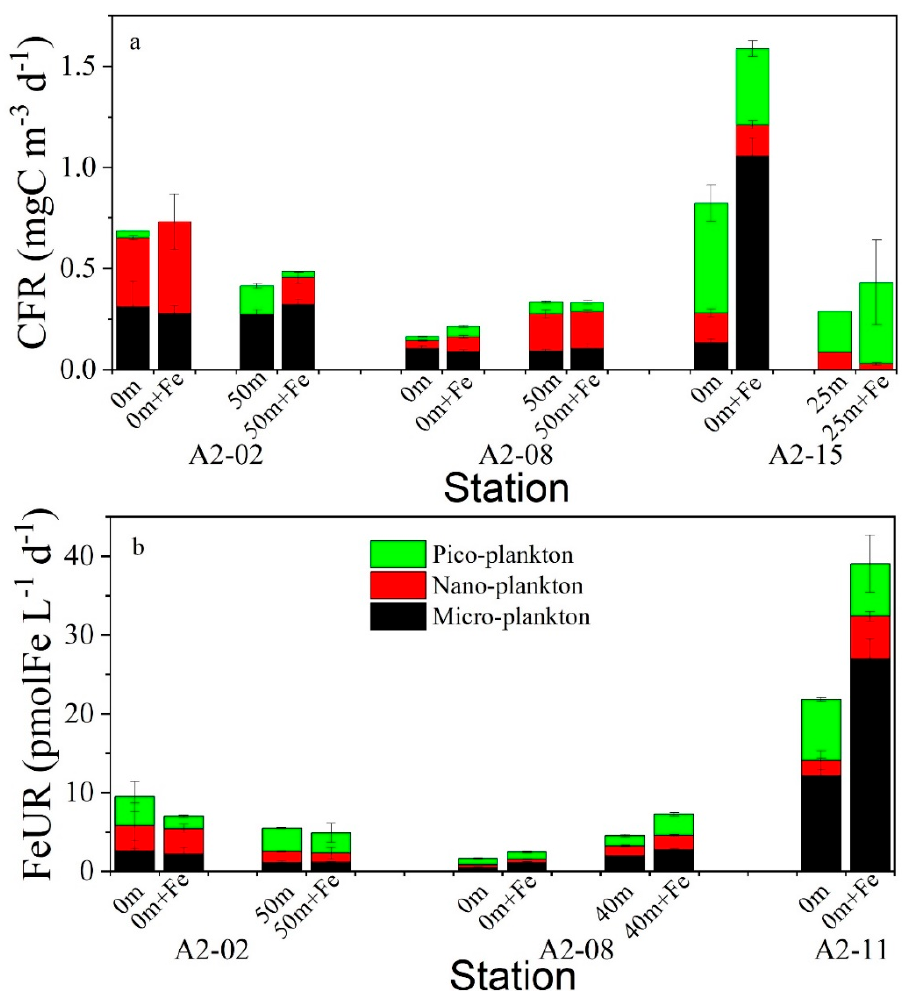
Figure 7. Effects of the DFe addition on the size-fractionated CFR ( a ) and FeUR ( b ). The black, yellow, and green bars represent micro-plankton, nano-plankton, and pico-plankton, respectively.